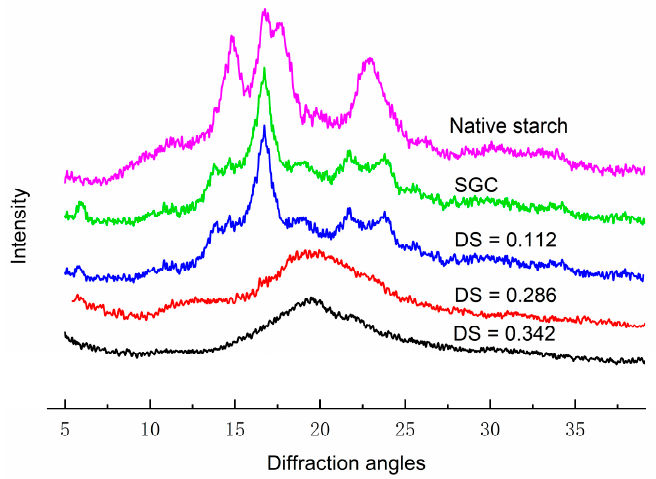
Figure 6. X-ray diffraction patterns of native waxy maize starch, SGC and OSA–SGC.